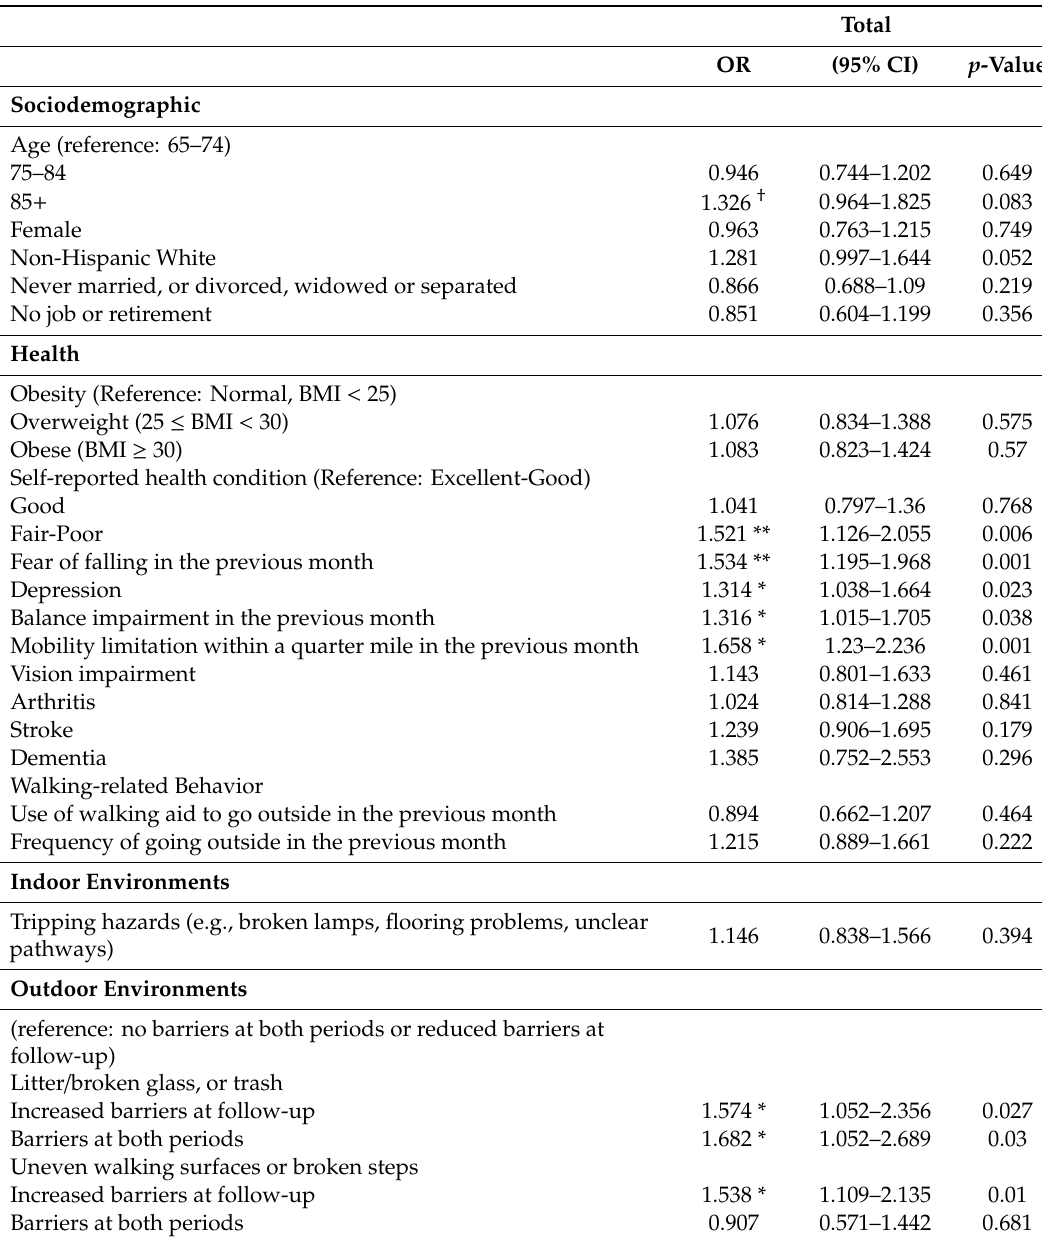
Table 3. Final multivariate model: falling risk